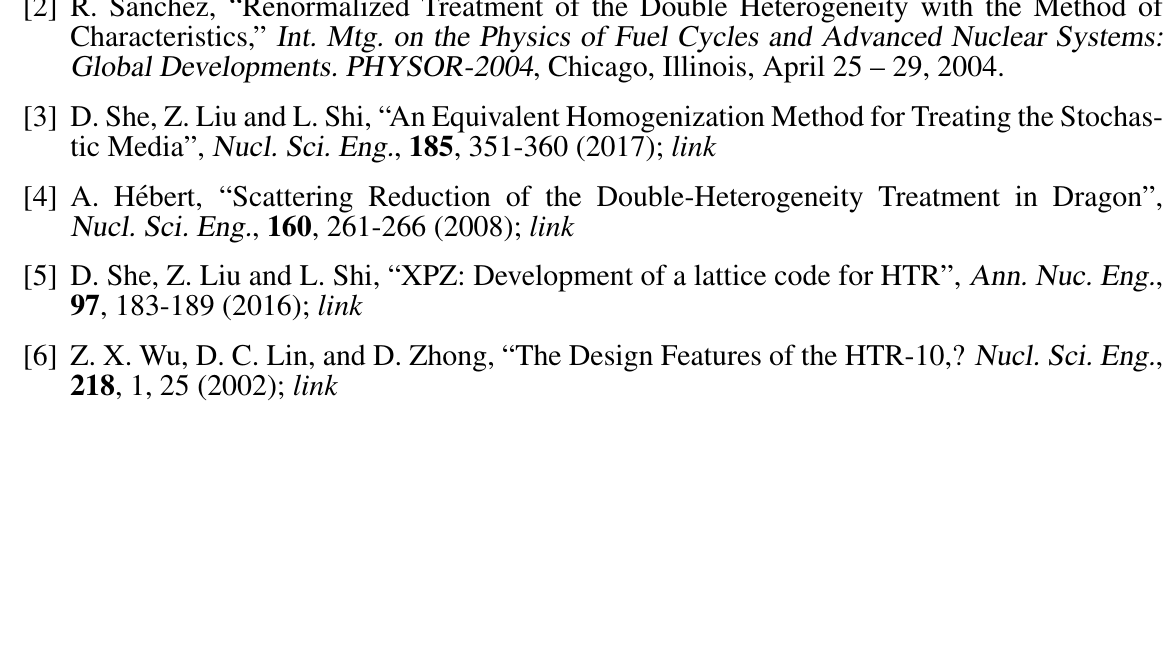
* RMC used as reference: k ∞ and ∆ k ∞ = ( k HEBE